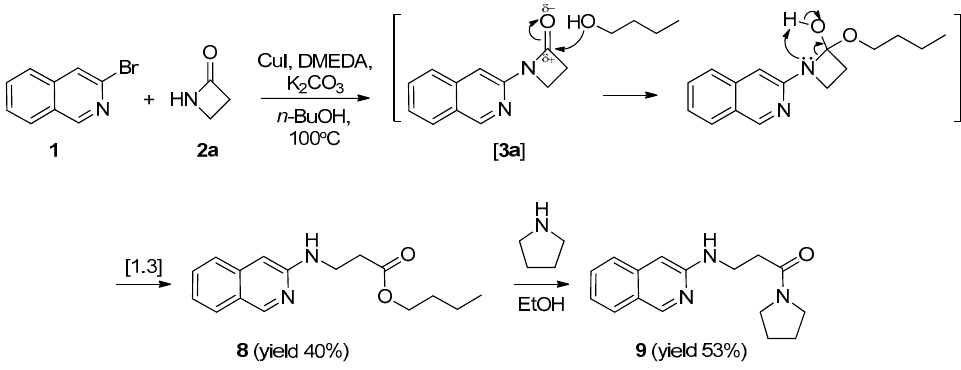
Figure 2 . Tapes formed via N-H···O and C-H···N interactions in the crystal structure of 3e . Short contacts are indicated with dashed lines. Absorption measurements were carried out using a Perkin-Elmer Lambda UV/VIS (Evolution 300 UV-vis) spectrophotometer. Spectra were recorded between 190 and 600 nm at 22 ± 2 °C. The fluorescence spectra of selected compounds 3a – f , 5 , 7a – d , 8 , and 9 were measured under the same conditions. The spectra of the test compounds were recorded in 0.1 M H 2 SO 4 solution. The photophysical properties data of the selected isoquinoline derivatives ( 3a – f , 5 , 7a – d , 8 , and 9 ) are summarized in Table 1. Due to the poor solubility in aqueous solution and organic solvents of the di-substituted isoquinolines 4a – c (minor products), their fluorescent properties were not investigated. Table 1 . Photophysical properties: molar absorptivity ( ε ), absorption maxima ( λ max abs. ), emission maxima ( λ max em. ), Stokes shift ( Δ υ ) and fluorescence quantum yield ( Φ fl ) of the selected isoquinoline derivatives in 0.1 M H 2 SO 4 *. Comp. R ε (M − 1 cm − 1 )